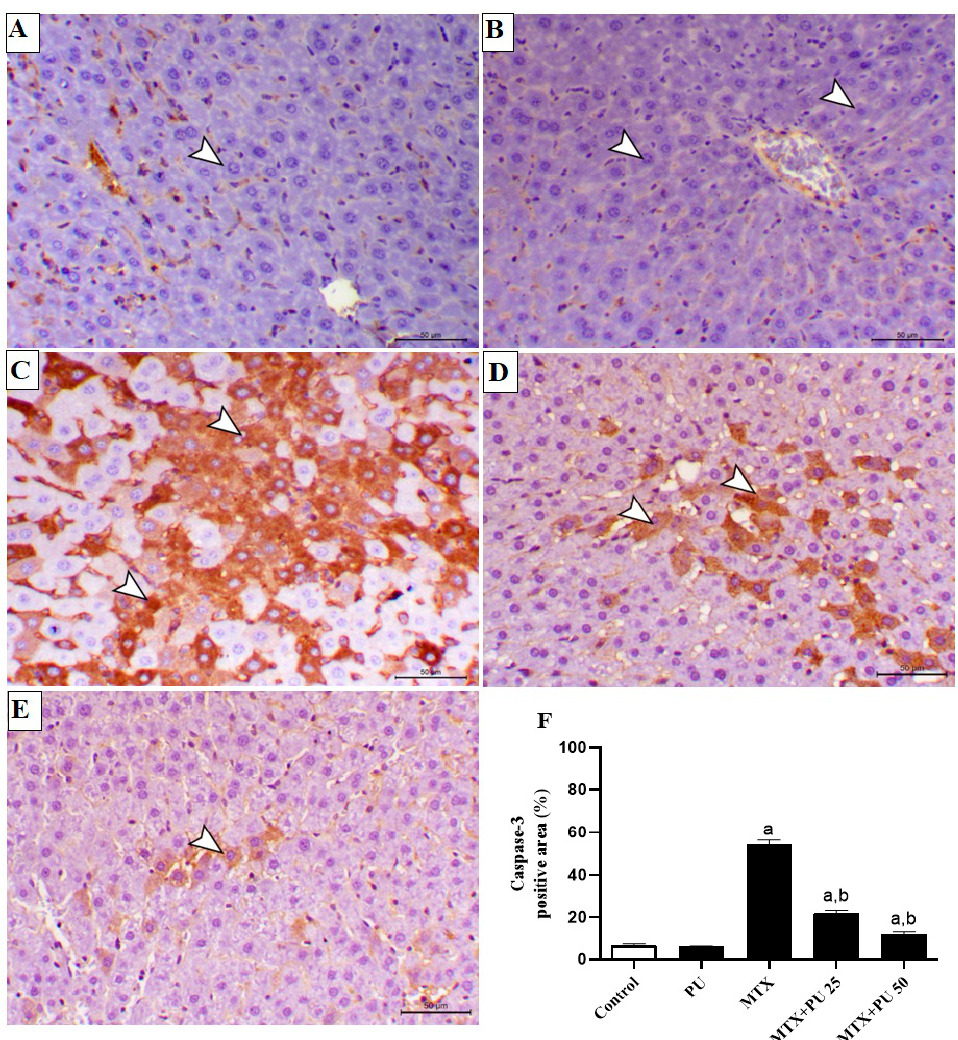
Figure 8. PU decreases hepatic caspase-3 in MTX-injected mice. Images of hepatic microscopic fields from ( A ) control and ( B ) PU-treated animals demonstrating slight immunoexpression of caspase-3 within the hepatic tissues (arrowheads); ( C ) MTX-administered mice showing marked immunoexpression of caspase-3 within the hepatic tissues (arrowheads); ( D ) MTX-intoxicated mice pre-treated with 25 mg PU demonstrating decreased caspase-3 immunoexpression within the hepatic tissues (arrowheads); and ( E ) MTX-injected mice pre-treated with 50 mg PU showing noticeable decreased hepatocytes’ caspase-3 immunoexpression (arrowheads) (IHC, X200, Scale bar = 50 µm). ( F ) Image analysis of hepatocytes’ caspase-3 immunostaining of mice demonstrating significant elevation in MTX-injected mice and significant decline in mice treated with both doses of PU. Results are expressed as mean ± SEM, ( n = 6). a indicates significant ( p < 0.05) vs. control, while b indicates significant ( p < 0.05) vs. MTX.